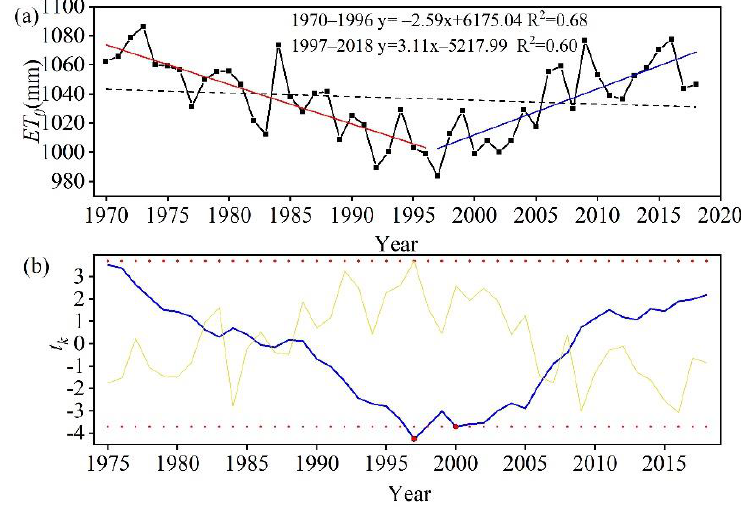
Figure 3. Variation of annual ET 0 ( a ) and Cramer’s test results for detecting change in annual ET 0 ( b ) on the TP from 1970 to 2018. (The red points represent the years in which the mutation occurred in the ET 0 series.) Table 1. Z value of reference evapotranspiration ( ET 0 ), solar radiation ( RS ), relative humidity ( RH ), air temperature ( T mean ) and wind speed ( U 2 ) in different periods.